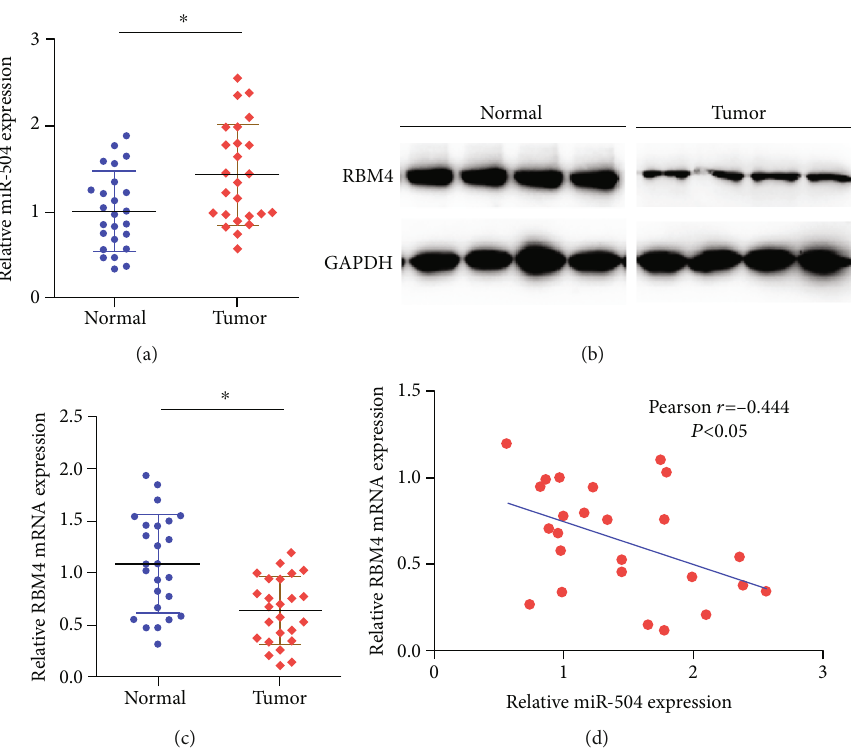
Figure 1: Relative expressions of miR-504 and RBM4 mRNA in normal and gastric cancer tissues. Relative expressions of (a) miR-504 mRNA and (b) RBM4 protein and (c) mRNA in normal ( n = 25 ) and gastric cancer tissues ( n = 25 ). (d) Pearson correlation analysis of miR-504 and RBM4 expressions in gastric cancer tissues ( n = 25 ). ∗ P < 0 : 05